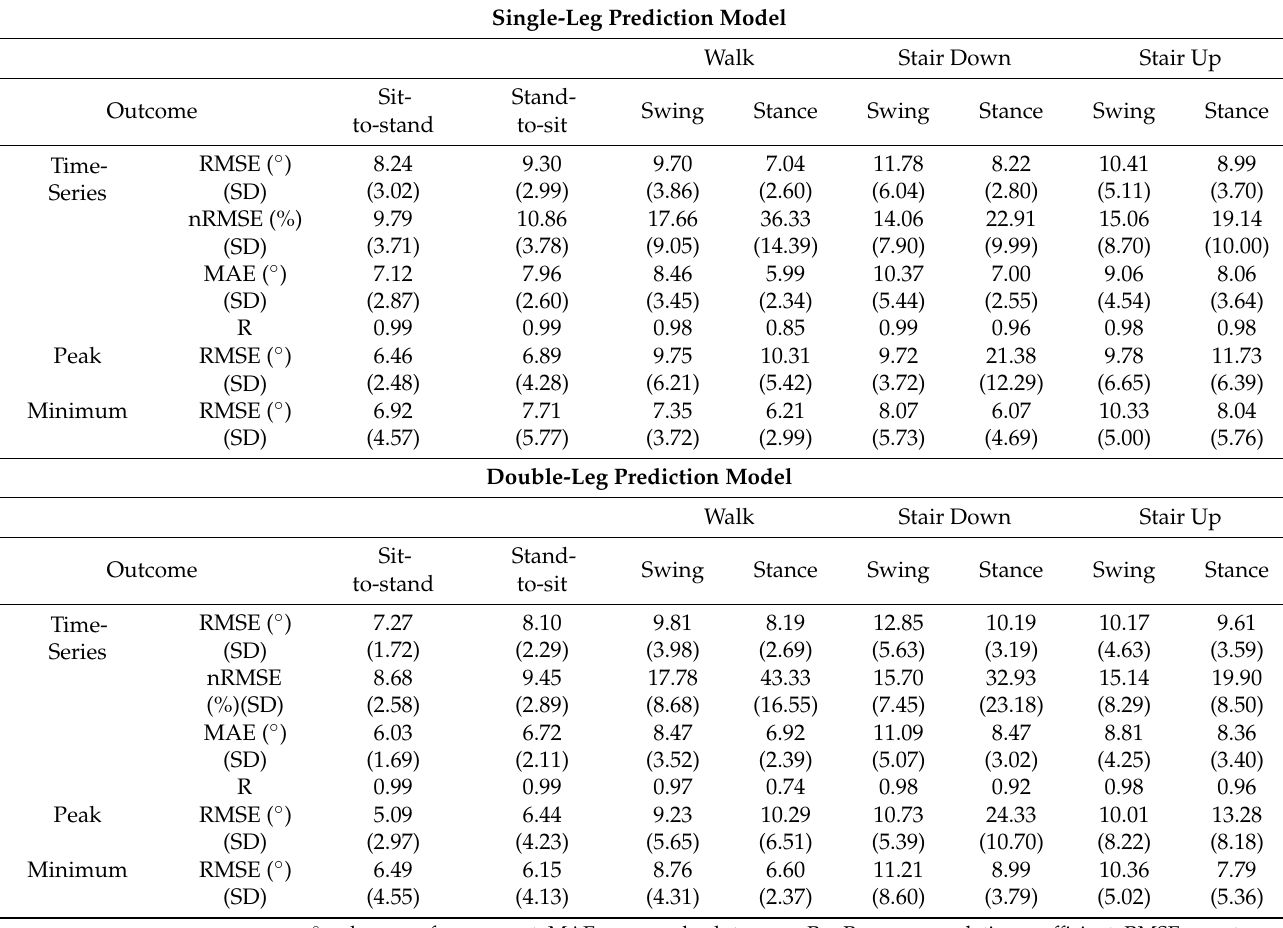
Table 3. Knee flexion angle prediction error for time-series, peak and minimum estimates for each